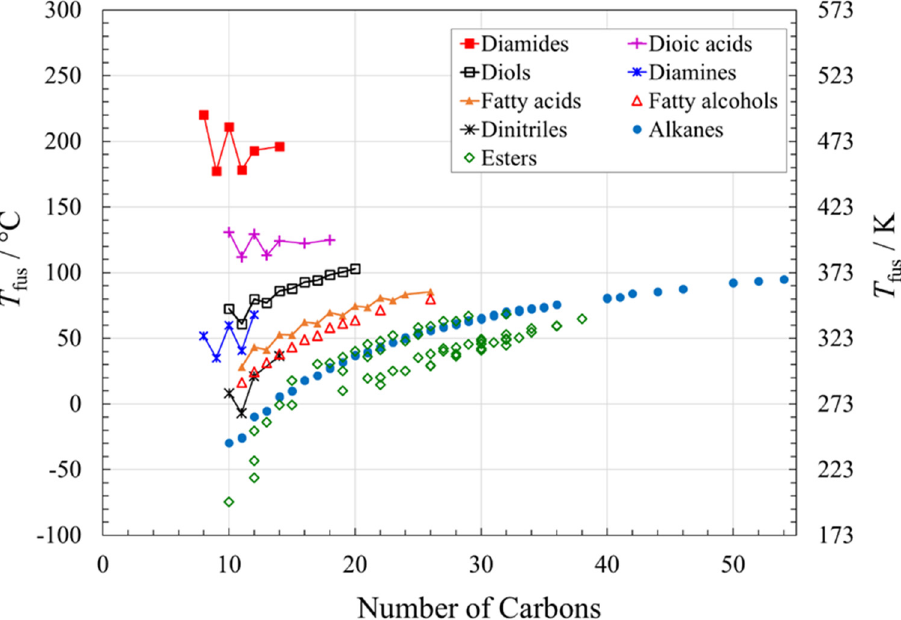
Figure 1. Melting points of nine families of long-chain, unbranched organic molecular solids, as a function of chemical family and total number of carbons in the compound. Lines are drawn between data points for some families, to emphasize odd–even effects, as described in the text. See Supplementary Information for data and data sources.